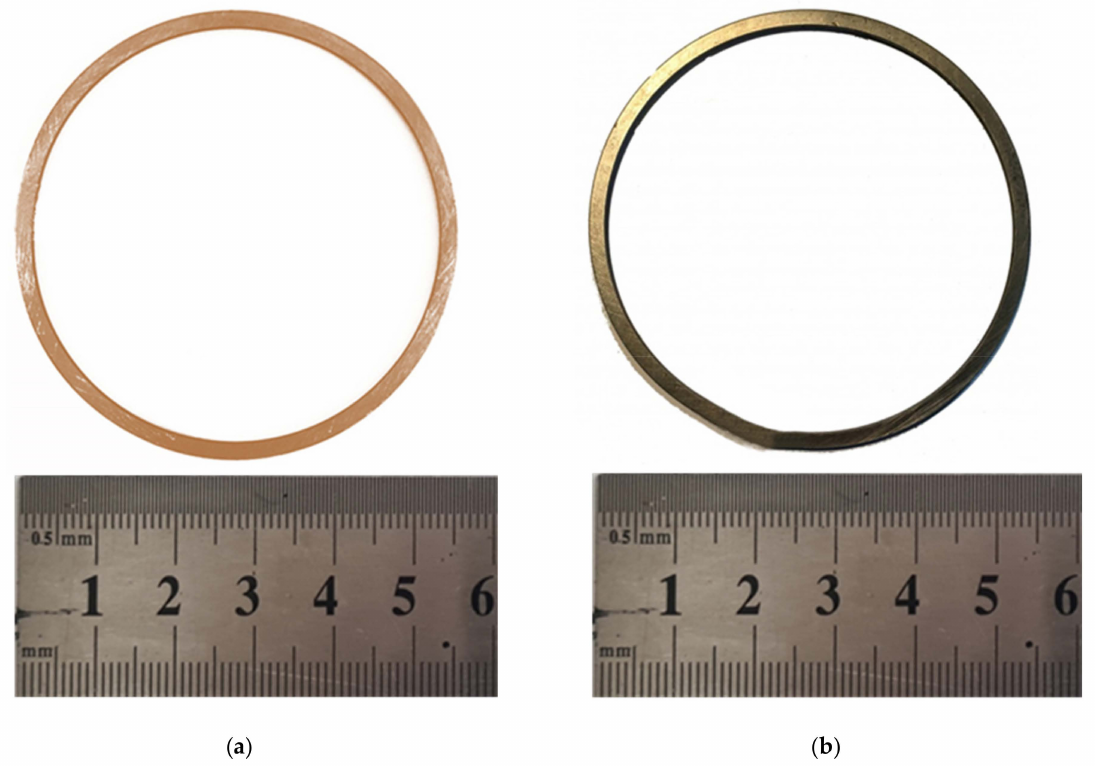
Figure 3. Type of workpieces: ( a ) initial state; and ( b ) after six deformation cycles by HPT